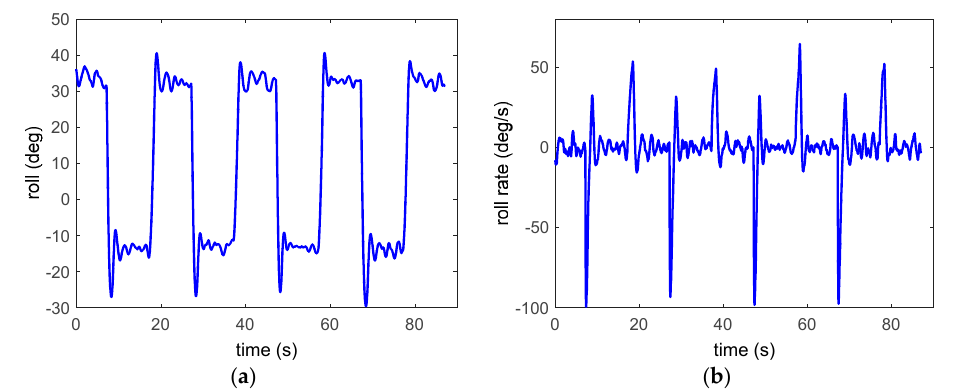
Figure 23. Wind tunnel 45 degree step responses ( a ) Roll angle; ( b ) Roll rate.